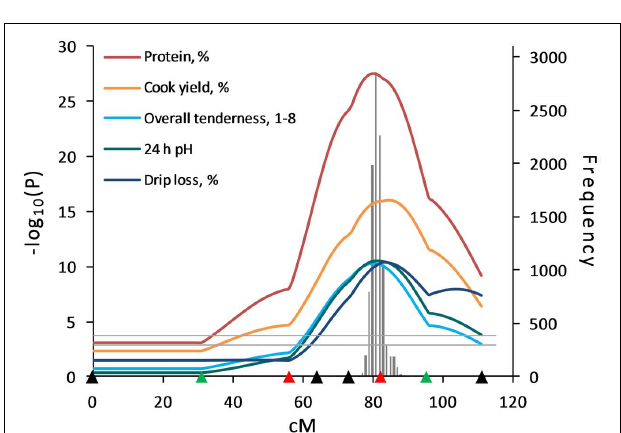
FIGURE 2 | Line-cross analysis indicated strong evidence for QTL influencing fat deposition traits on SSC6. Highly significant QTL for traits related to fat deposition were identified on SSC6. Confidence intervals for fat percentage and 10th-rib backfat (BF10) were estimated using 10,000 bootstrap permutations as 136–146cM (blue bar) and 159–165cM (red bar), respectively. Marker positions are shown as triangles on the X -axis (black, markers used for both QTL scans and genotyped only in 510 animals; green, markers used for both QTL scans and genotyped in all animals; red, markers used for second scan only and genotyped in all animals). Horizontal lines indicate significance thresholds (lower line, 5% FDR; upper line, 1% FDR).